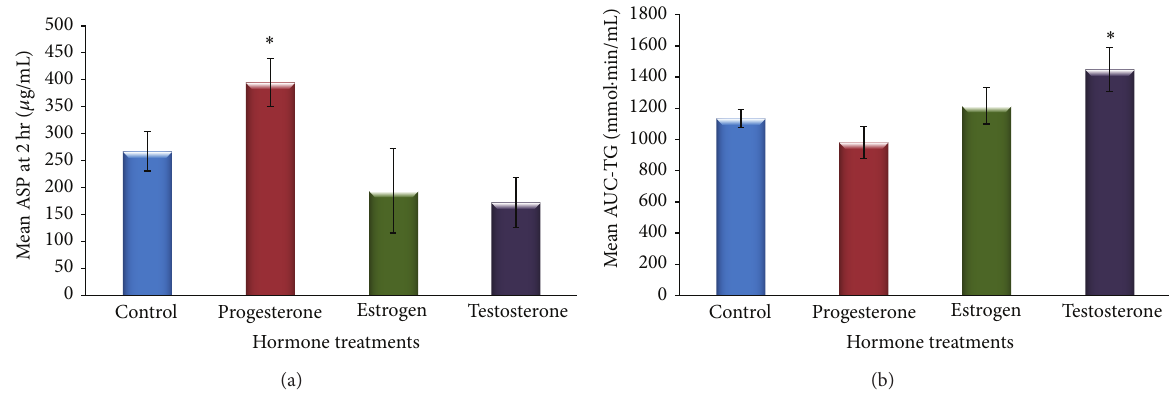
Figure 3: (a) ASP levels at 2hrs showed that the greatest difference in ASP levels was between the progesterone treated group and the testosterone treated group ( 𝑃 = 0.049 ). (b) Areas under the curves (AUCs) for postprandial changes in plasma triglyceride (TG) concentrations for the different hormone treated groups and control group were measured to represent postprandial TG clearance after a fat load. The greatest difference in TG-AUC was greatest between the progesterone treated group and the testosterone treated group (0.041). Results are expressed as mean ± SEM. Significant differences were set at ∗ 𝑃 < 0.05 .